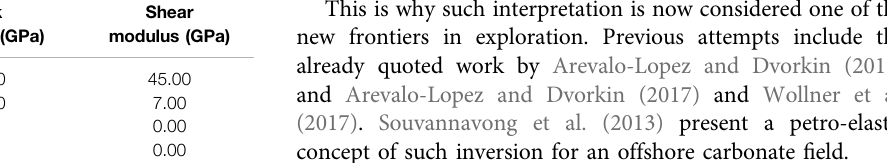
TABLE3| Densitiesandelasticmoduliofthemineralsandpore- fl uidphasesused in rock physics modeling. Mineral/ Fluid